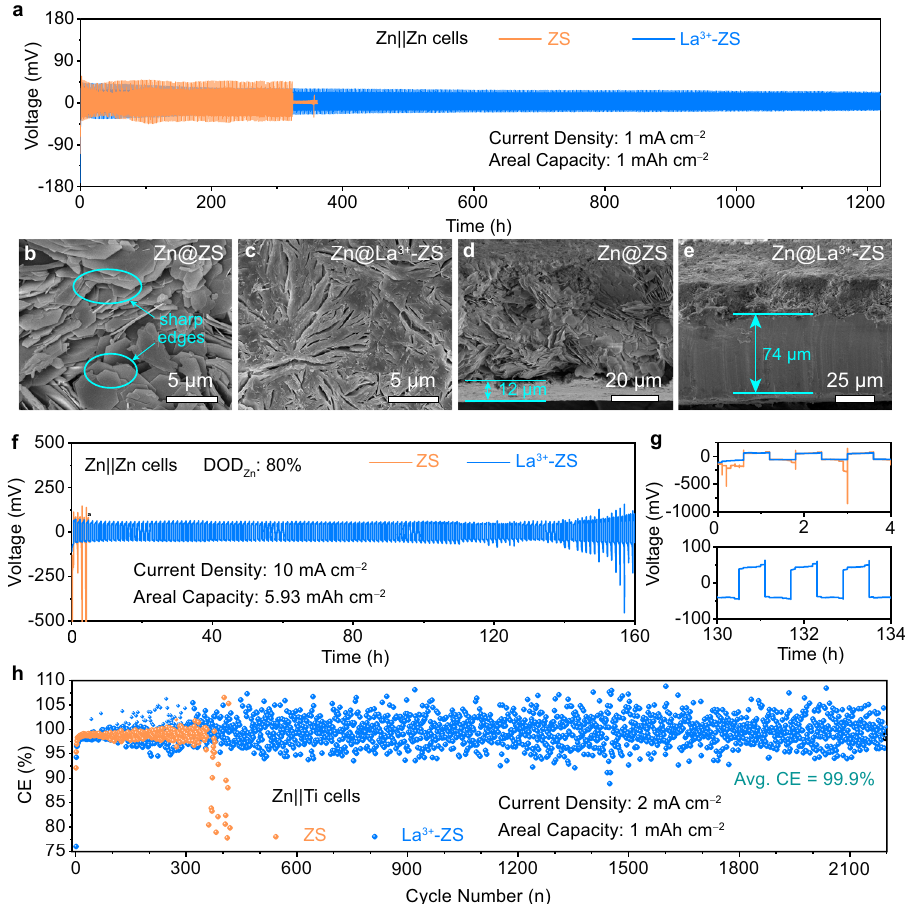
Fig. 1 The plating/stripping behaviors for Zn electrodes in ZS and La 3 + -ZS electrolytes. a Cycling performance of the Zn||Zn cells with a current density of 1 mA cm − 2 and an areal capacity of 1 mAh cm − 2 ; the top and cross-sectional SEM images of the Zn electrodes for Zn||Zn cells in ( b, d ) ZS and ( c, e ) La 3 + -ZS electrolytes after 100 cycles under a current density of 1 mA cm − 2 for 1 h. f Cycling performance of the Zn||Zn cells with a limited Zn supply (DOD Zn = 80%), a current density of 10 mA cm − 2 , and an areal capacity of 5.93 mAh cm − 2 . g The selected enlarged voltage pro fi les of ( f ). h CE of the Zn|| Ti cells with a current density of 2 mA cm − 2 and a cut-off charging voltage of 0.4